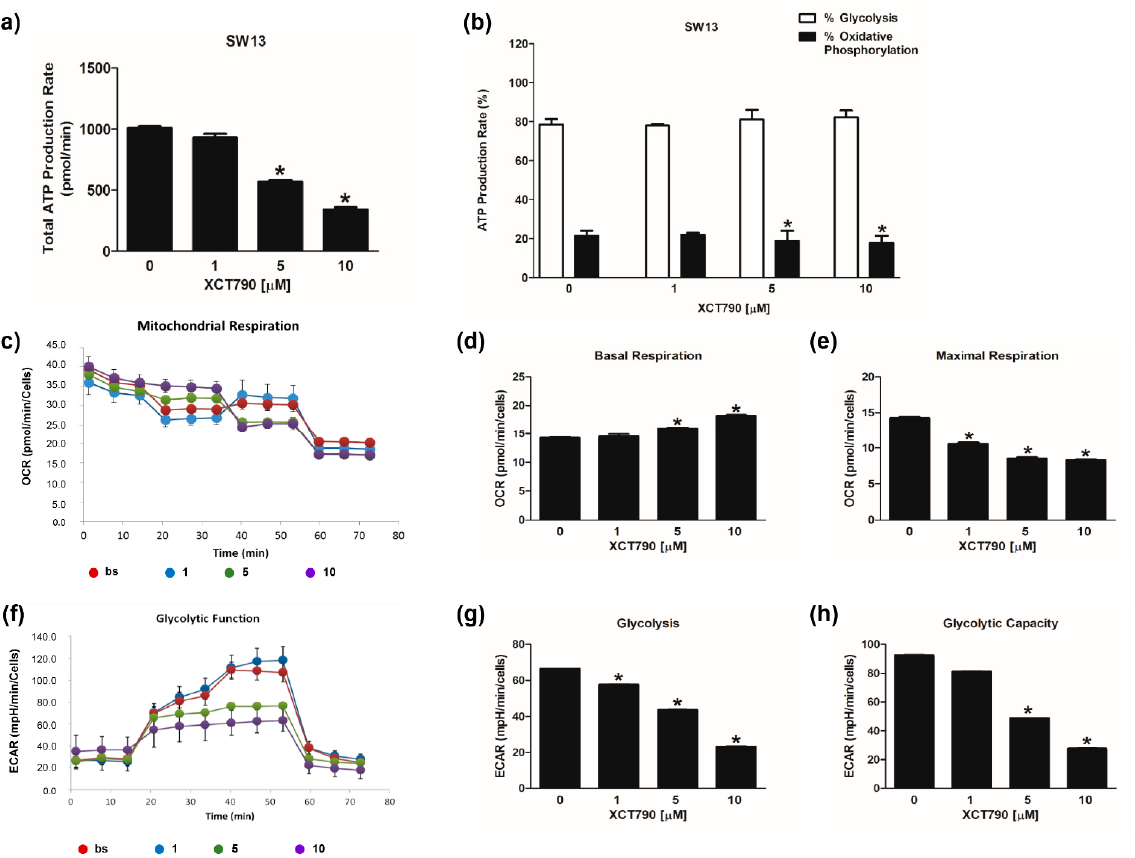
Figure 4. Effect of XCT790 treatment on SW13 cell metabolism. The metabolic profiles of SW13 cells untreated (0) or treated with XCT790 (1, 5, 10 µ M) for 18 h were assessed by Seahorse XFe96 analyzer. ( a , b ) ATP Rate Assay was evaluated as indicated in “Materials and Methods”. Graphs represent the mean ± SD of three independent experiments of Total ATP Production Rate (pmol/min) ( a ) and ATP production (%) ( b ) derived from glycolysis and oxidative phosphorylation after the sequential addition of specific inhibitors (* p < 0.05 vs. 0). ( c – e ) Mitochondrial Stress Analysis was performed as indicated in “Materials and Methods”. Graphs represent the mean ± SD of three independent